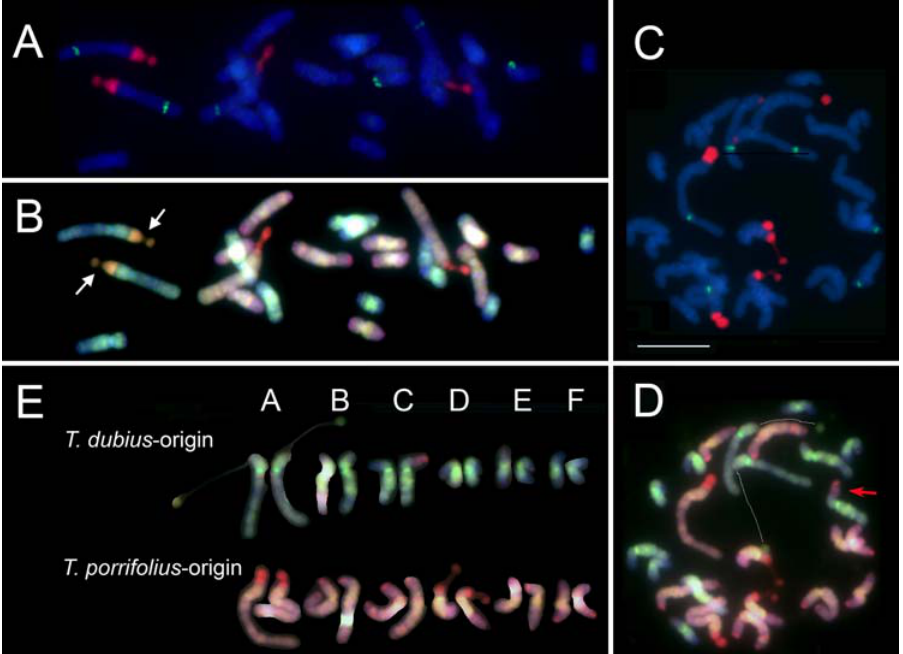
Figure 5. Analyses of root tip metaphases of synthetic T.mirus (A, B is plant 73-14; C-E is plant 134-16-3). (A, C) Metaphase (merged images) after FISH for 45S rDNA (red) and 5S rDNA (green) and counterstained with DAPI (blue). (B) and (D) Metaphases (merged images) from (A) and (C), respectively, after reprobing using GISH with labeled genomic DNA from T. porrifolius (pink) and T. dubius (green) and counterstained with DAPI. In (B) note the particularly there are only four 45S rDNA sites, the sites on A du. Chromosomes are particularly large (arrows) and the site expected on chromosome D po is missing. In (D) note the T. porrifolius translocation to a T. dubius chromosome (red arrow) and the satellites to both A du homologues are distant from the rest of the chromosome (see connecting white lines). (E) Karyotype of (D) revealing that the T. porrifolius origin translocation is to chromosome C du and that no T. porrifolius chromosomes lack chromatin. Scale bar is 10 m m.